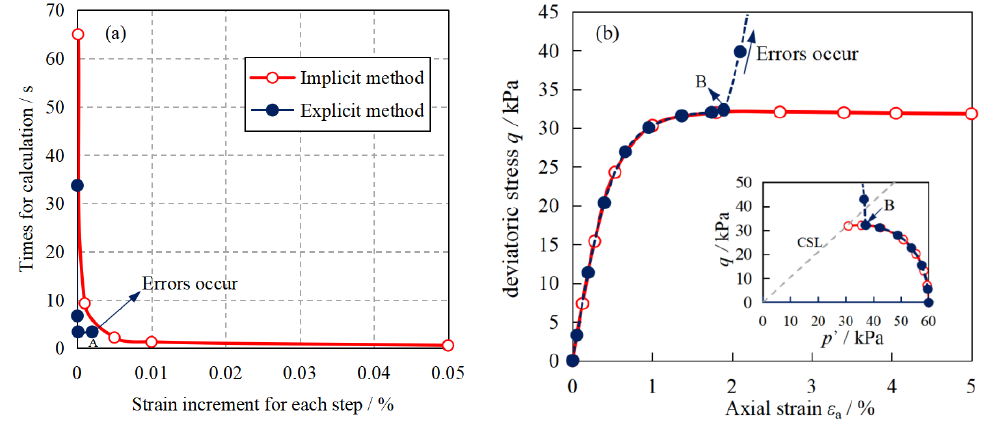
Figure 8. Comparisons between implicit algorithm and explicit algorithm ( a ) computation time ( b ) accuracy.